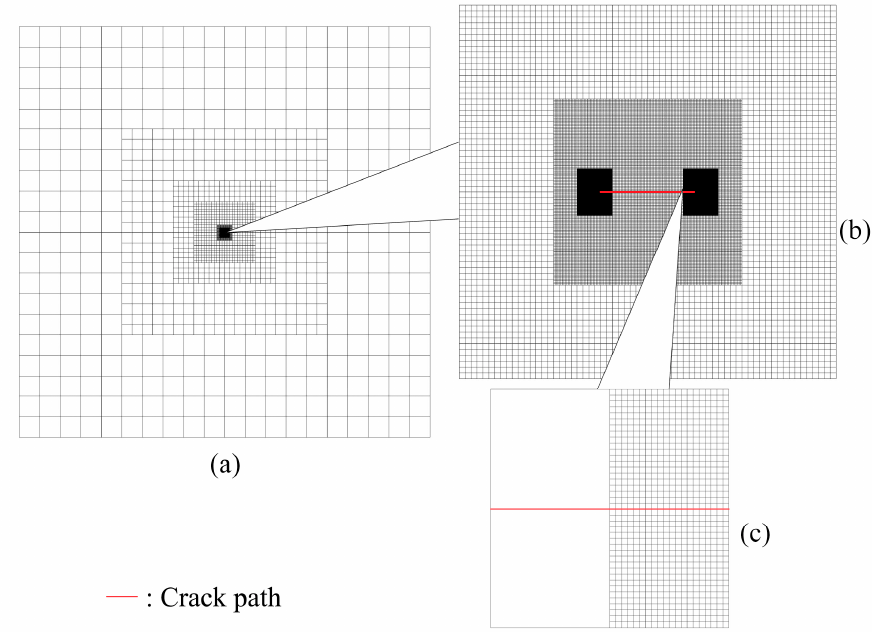
Figure 9. ( a ) Global mesh (in this view, the size of the largest element is 32 mm × 32 mm); ( b ) Mesh from the view of the 5th-level refinement domain (in this view, the size of the largest element is 0.25 mm × 0.25 mm); ( c ) Comparison between the elements from the 7th-level refinement domain and the elements from the 6th-level refinement domain (in this view, the size of the largest element is 0.0625 mm × 0.0625 mm). Table 1. Configuration of the simulation.